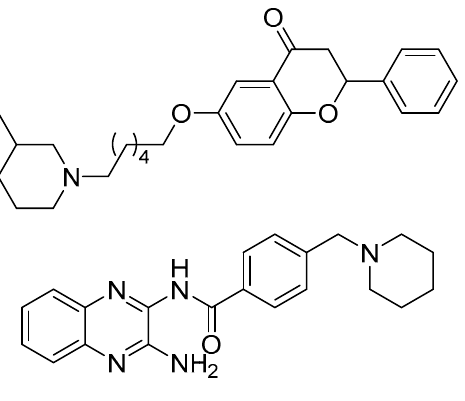
Data for comp. ( 17 )